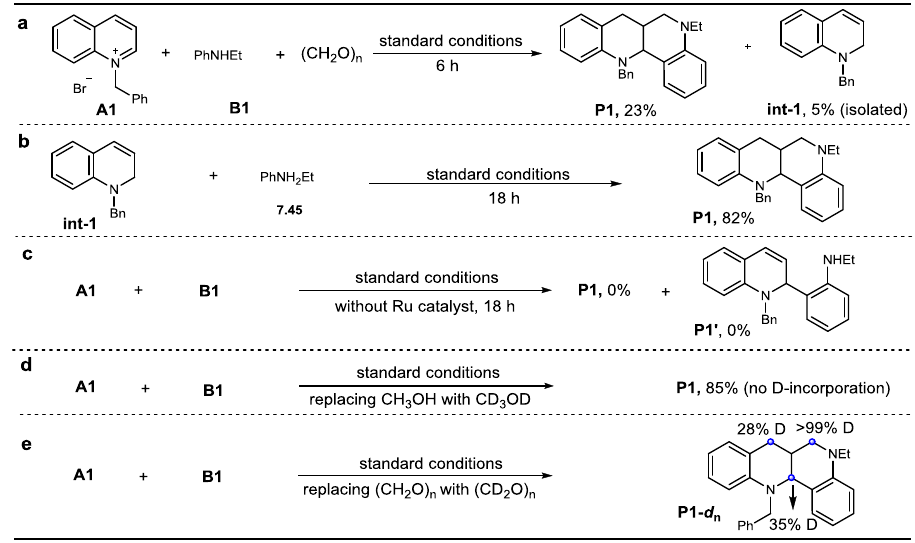
Fig. 6 Control experiments for mechanistic studies. a Intermediate Detection. b Intermediate veri fi cation. c Ruling out possible reaction step. d , e Deuterium-labeling experiments to verify hydrogen donor and C1